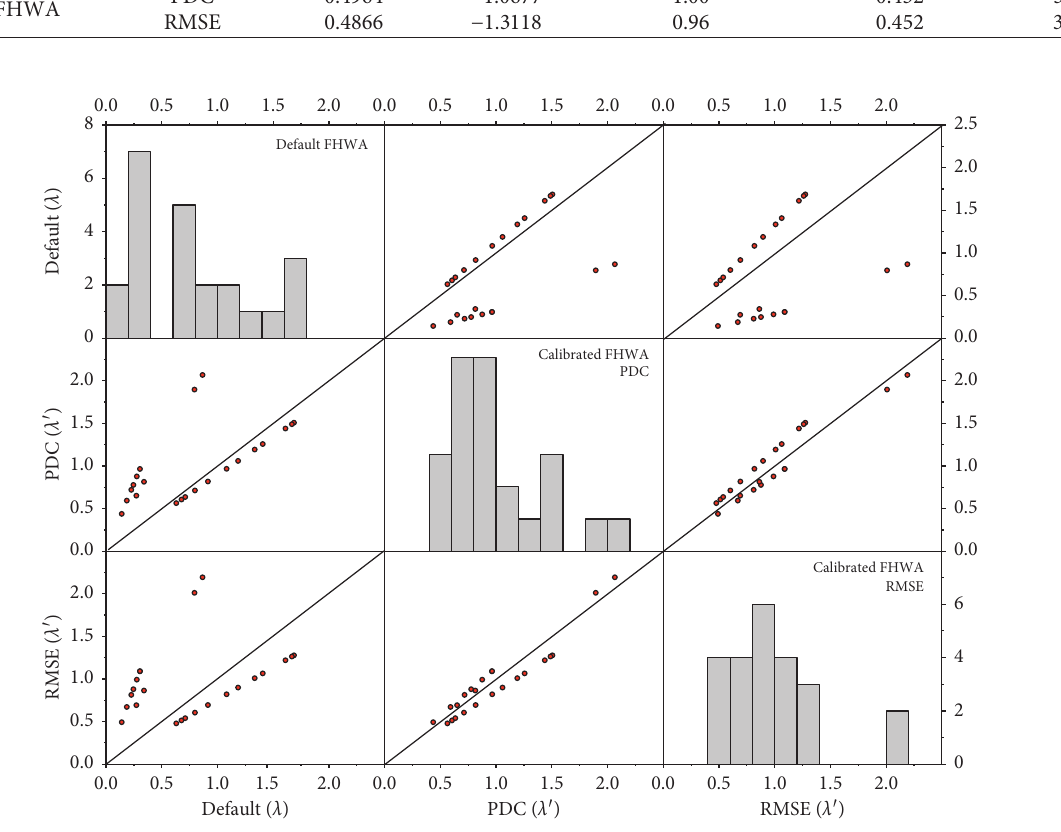
Figure 4: Histograms and comparisons of model biases λ and λ ′ .